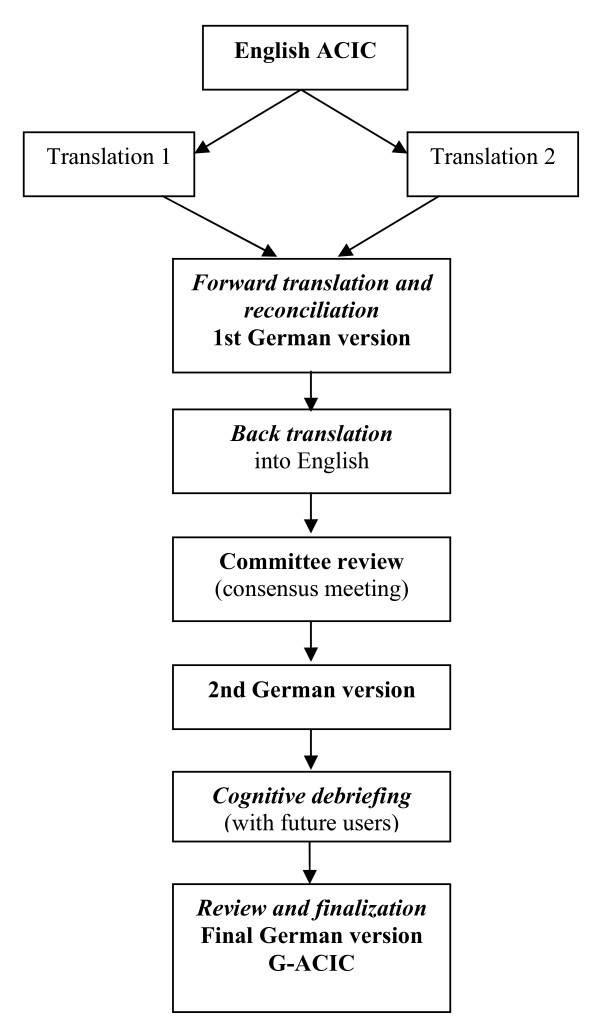
Translation process.